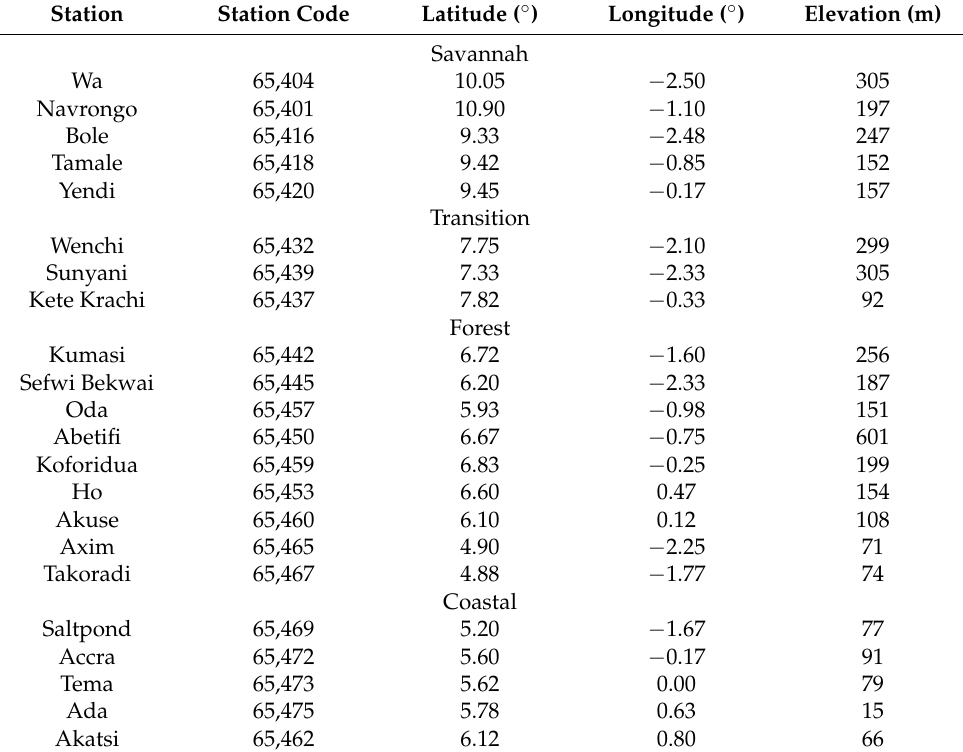
Figure 1. Map of the study area showing all 22 synoptic stations distributed in four main climatologi- cal zones countrywide. Adapted from Asilevi et. al. [9]. Table 1. Geographical position and elevation for selected